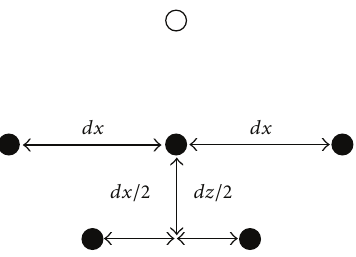
Figure1:Interactionbetweenfluidparticlesandboundaryparticles.